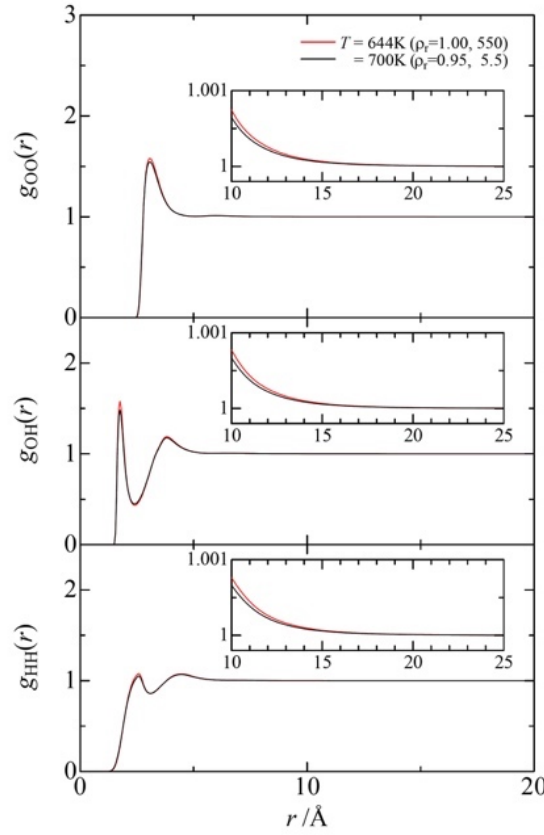
Figure 9. The RDFs for the O–O site pair on the ridge over a wide range of site–site separations. Numbers in parentheses in the figure legend denote the relative number density and the value of density fluctuation at that point, respectively. This figure is reprinted with permission from JCP , 2014 , 140 , 104511. Copyright 2014 AIP Publishing.